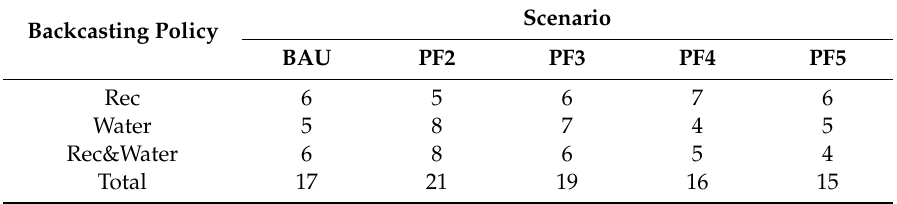
Table 16. The number of average ES levels (out of 10, all 10 average ES levels are presented in Table 12) that stay the same or move towards the desired end point, by potential future (PF) and backcasting policy in the WP